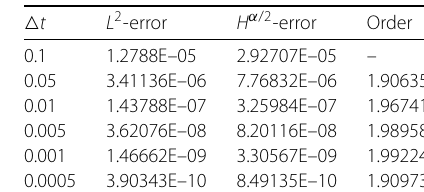
Table 4 The L 2 and H α /2 numerical errors at α = 1.7 for various temporal resolutions v